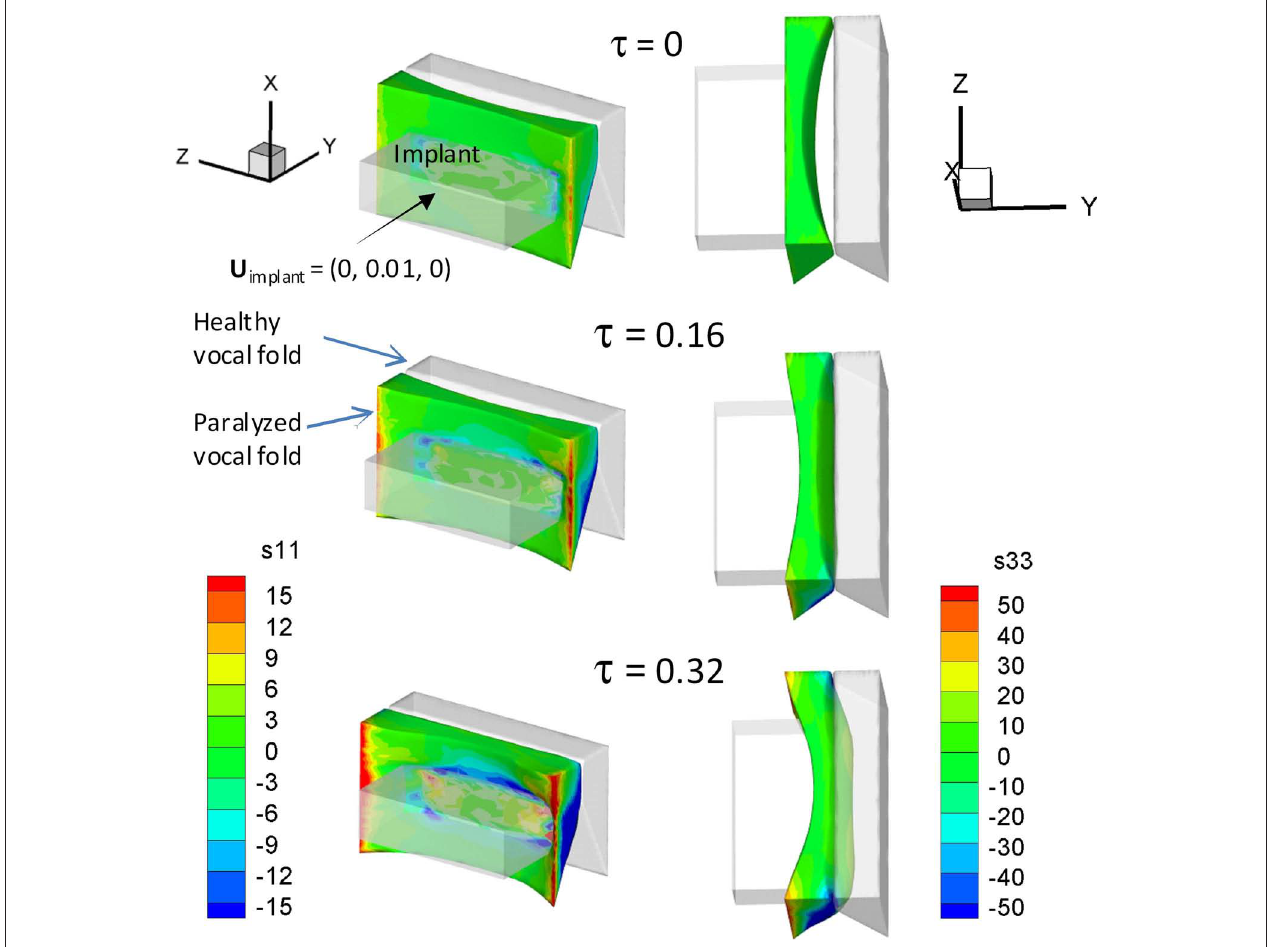
Figure 5 | Simulation of the deformation of paralyzed vocal fold during the implant